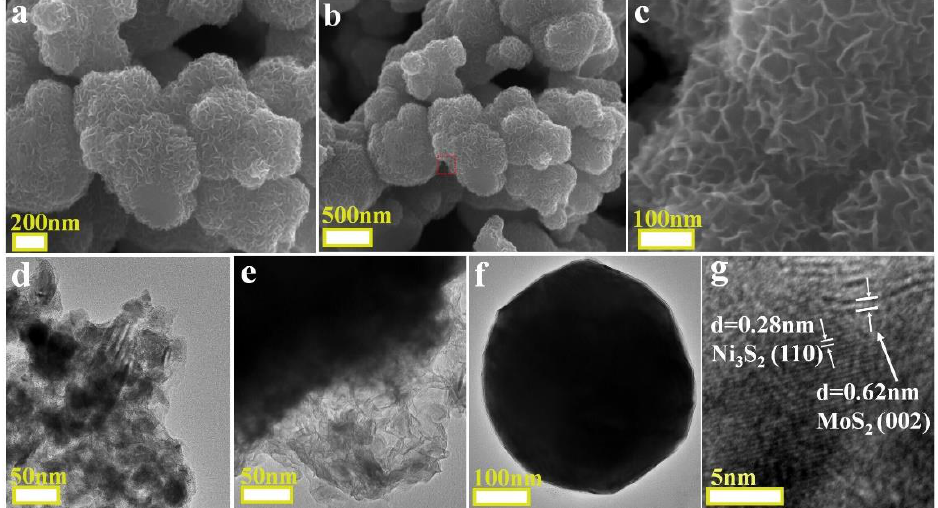
Figure 2. ( a ) SEM image of Fe, C-Mo y S x /NiS, ( b,c ) Fe, C-MoS 2 /Ni 3 S 2 -450; ( d–g ) TEM image of Fe, C- MoS 2 /Ni 3 S 2